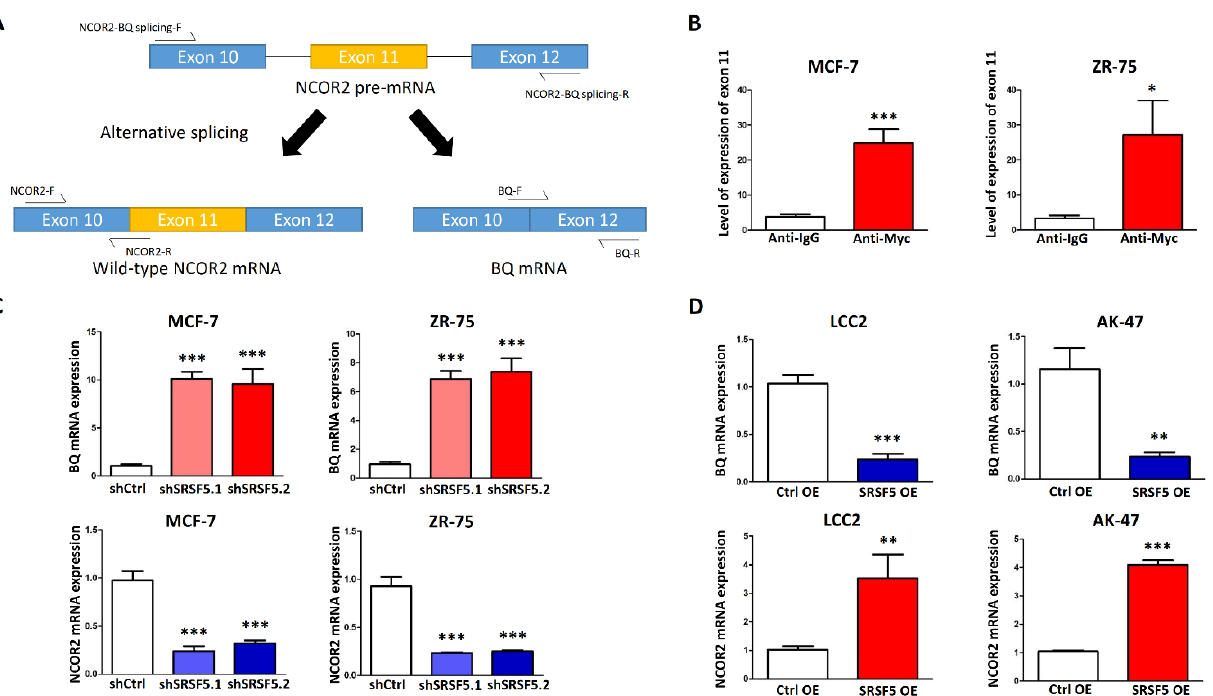
Figure 2. SRSF5 bound to exon 11 of NCOR2 to facilitate the splicing process to generate NCOR2 mRNA. ( A ) Schematic diagram of splicing event that produces NCOR2 and BQ. The arrows indicate the positions of the specific primers used for detecting NCOR2-BQ splicing (NCOR2-BQ splicing -F and -R), NCOR2 and BQ. The diagram is not in scale. ( B ) SRSF5 could bind to exon 11 of NCOR2.